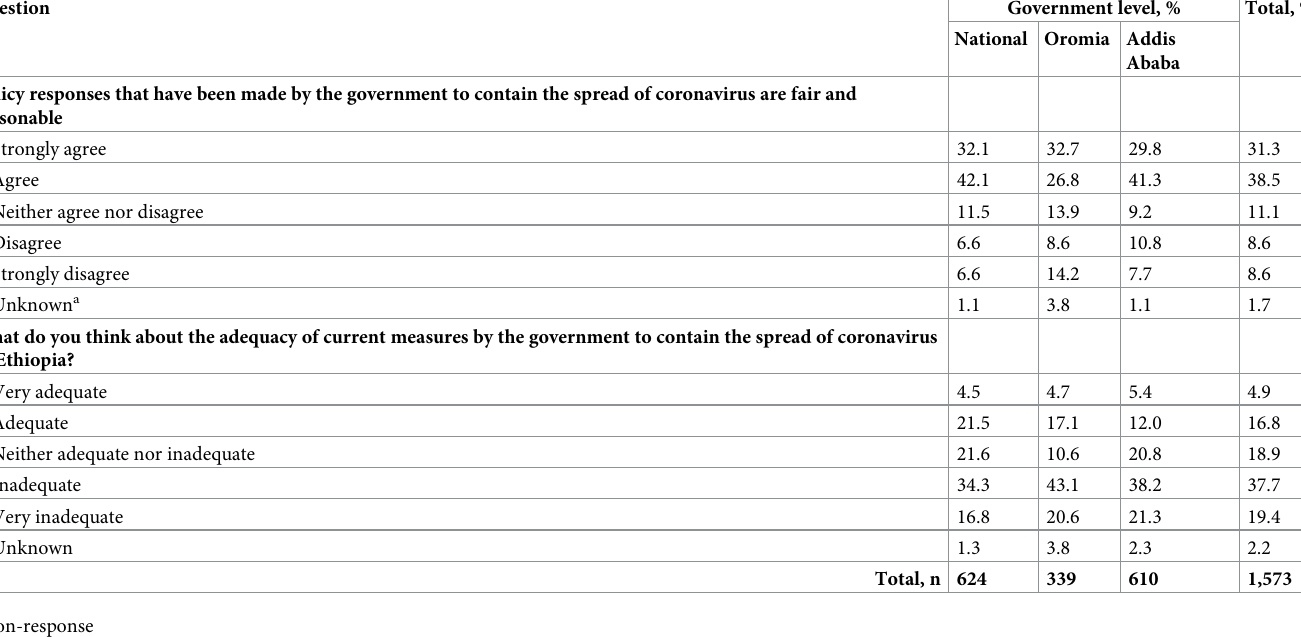
Table 5. Perception of respondents about policy responses to contain the spread of coronavirus in Ethiopia, Addis Ababa, June